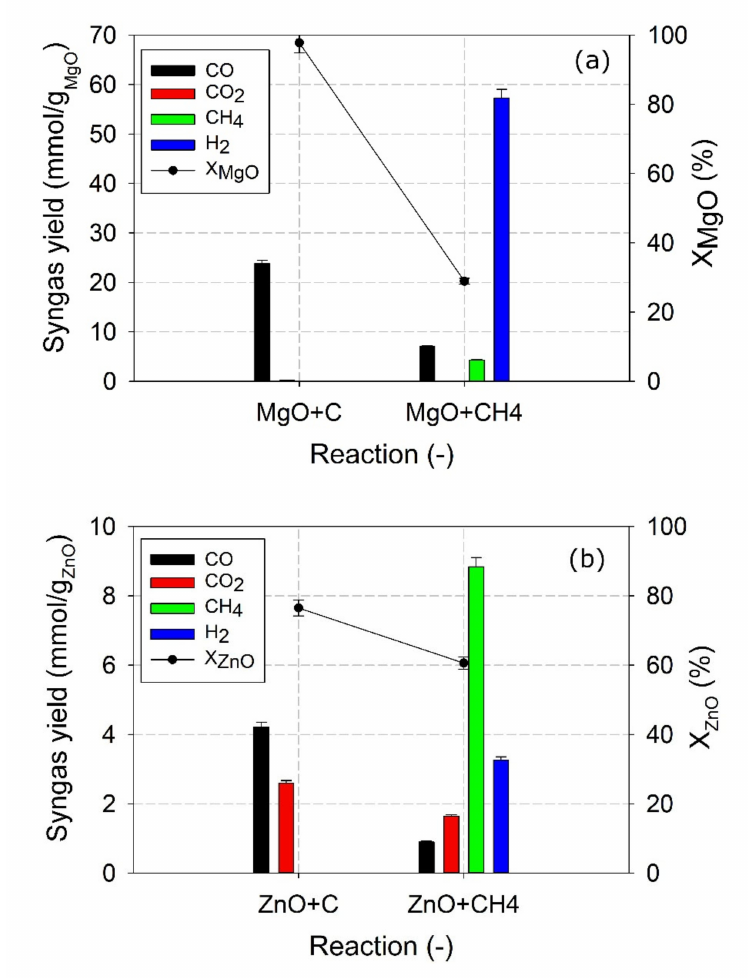
Figure 8. Syngas yields and MO conversion: ( a ) the CTR of MgO vs. the MTR of MgO and ( b ) the CTR of ZnO vs. the MTR of